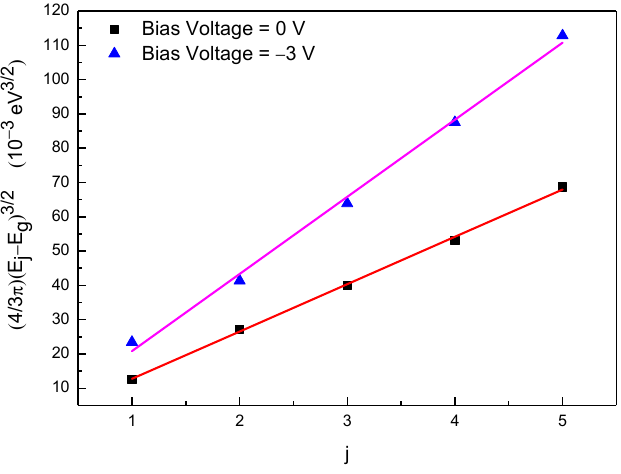
Figure 2. Plot of (4/3 π )( E j − E g ) 3/2 as a function of index j for sample A.